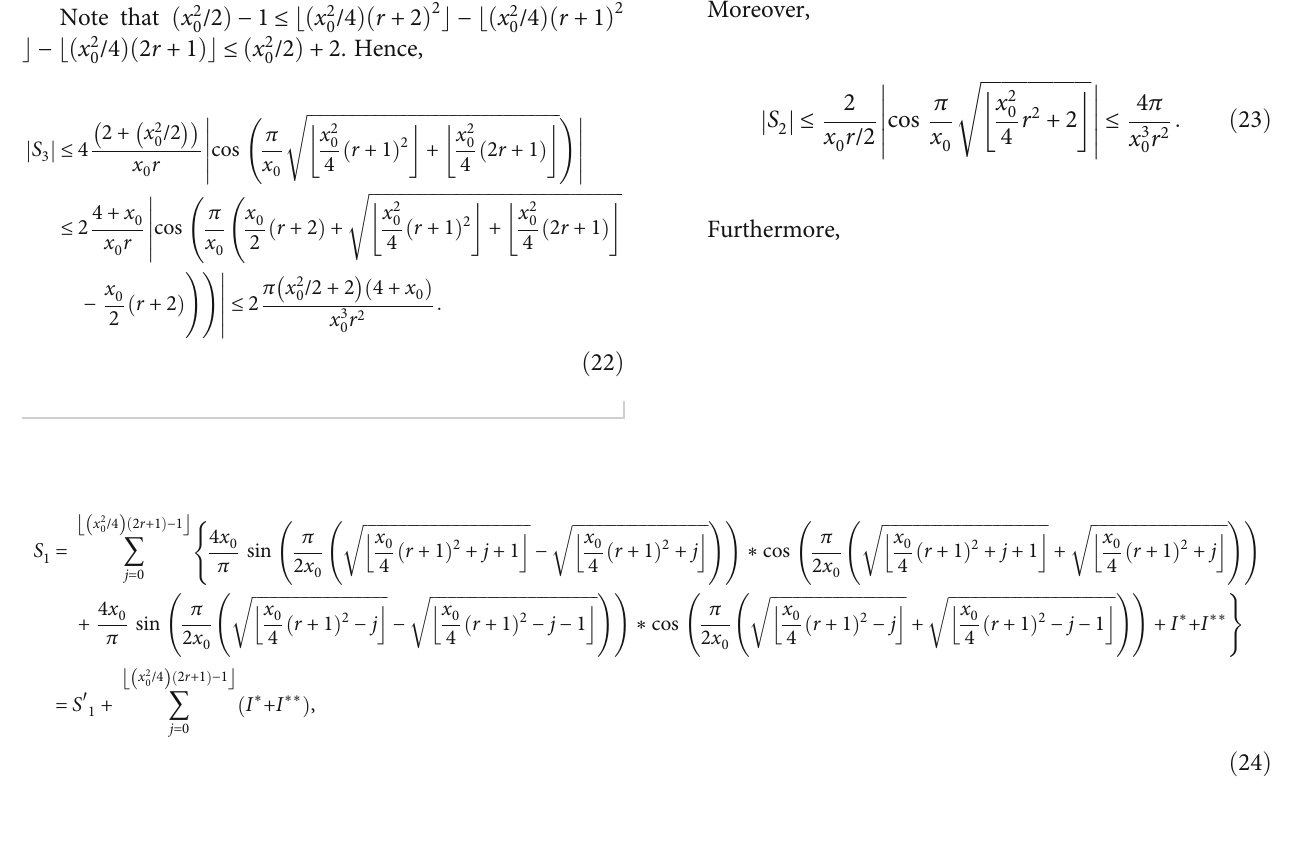
ffiffiffiffiffiffiffiffiffiffiffiffiffiffiffiffiffiffiffiffiffiffiffiffiffiffiffiffiffiffiffiffi x 2 0